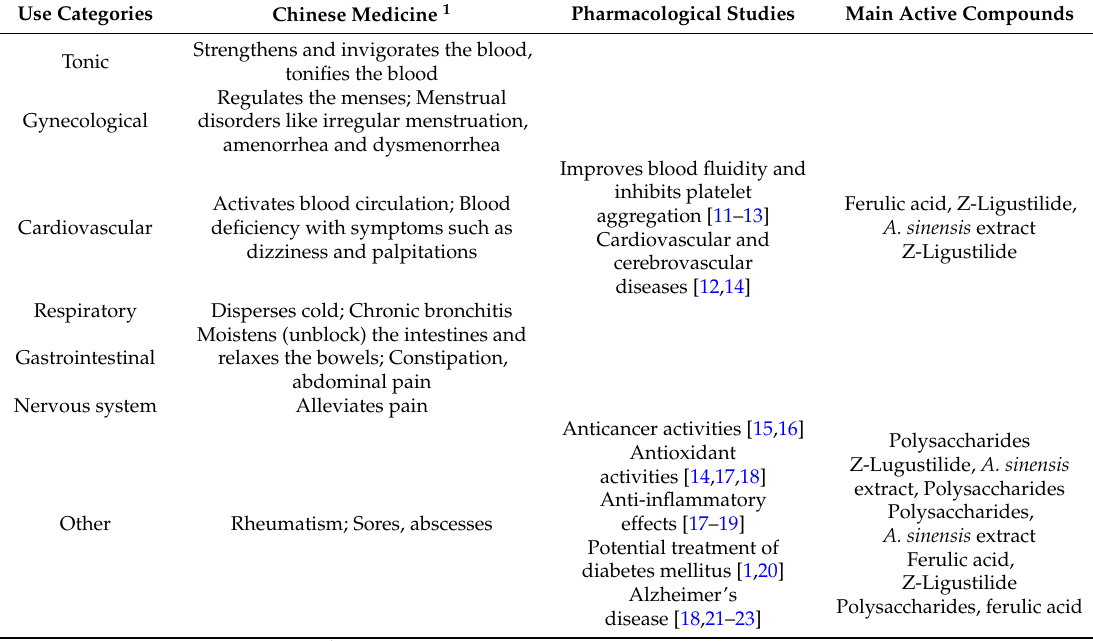
Table 1. Effects and indications of Angelica sinensis roots according to Chinese medicine and current pharmacological